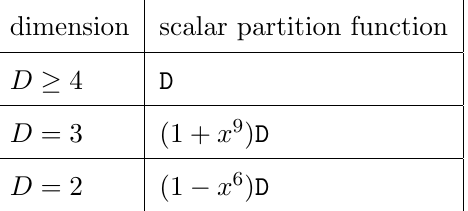
Table 5 . Partition function over the space of Lagrangians involving four (cid:30) ’s. This includes both parity even and parity odd Lagrangians. D (cid:17) 1 = ((1 (cid:0) x 4 )(1 (cid:0) x 6